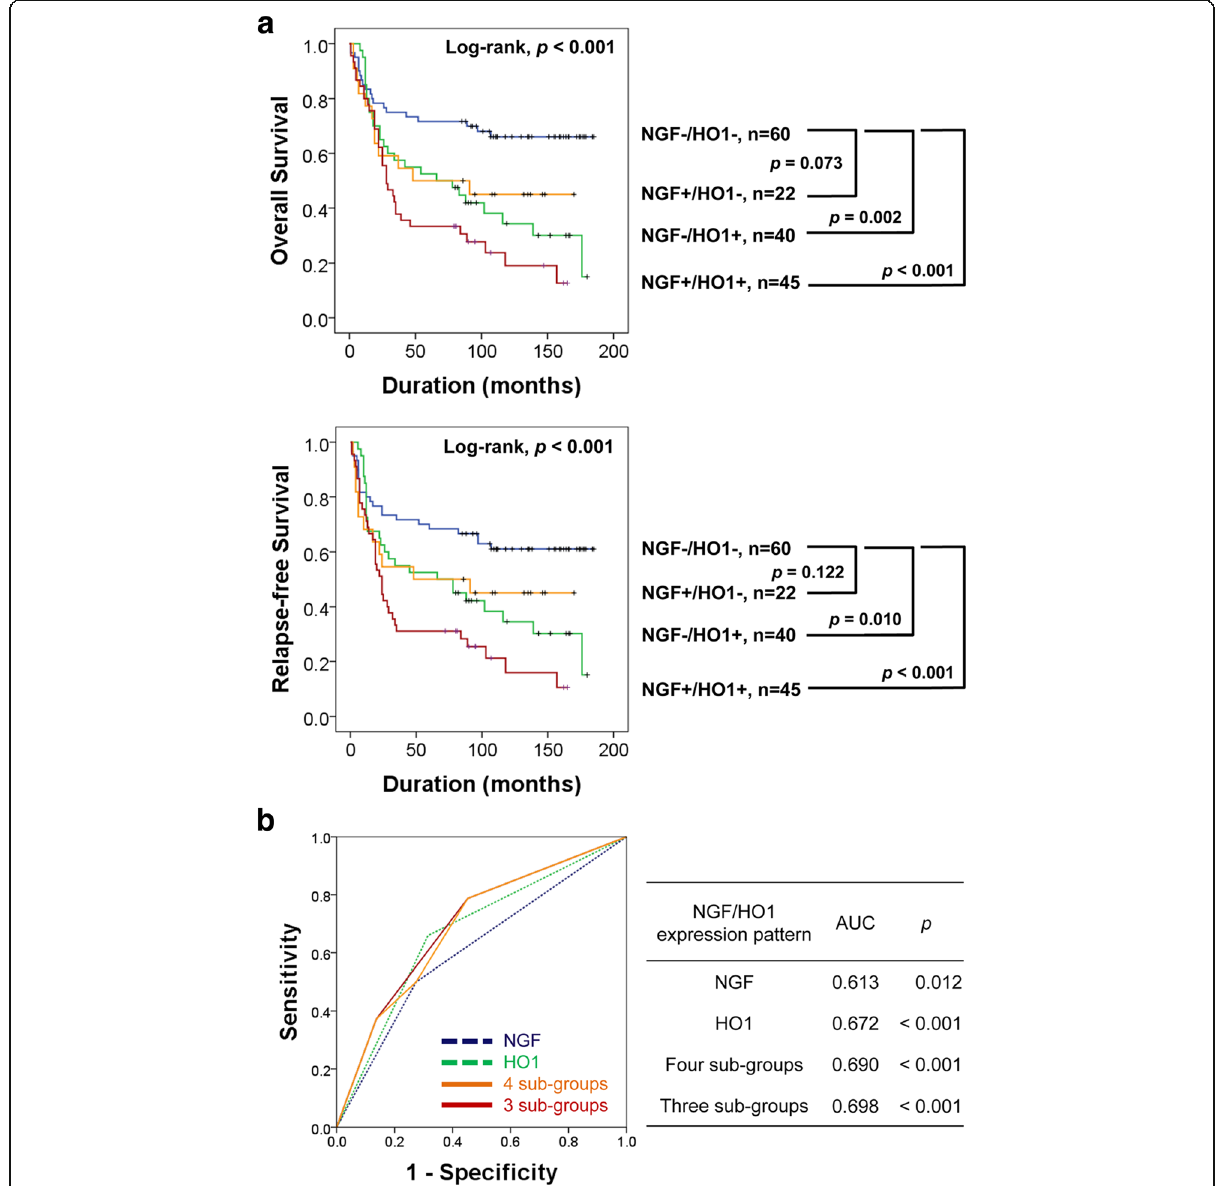
Fig. 3 Kaplan-Meier survival analysis and statistical analysis according to the individual and co-expression pattern of NGF and HO1 in gastric carcinomas. a Gastric carcinomas were grouped into four sub-groups according to co-expression pattern of NGF and HO1 and subjected to Kaplan-Meier survival analysis for the overall survival and relapse-free survival. NGF − /HO1 − , NGF-negative and HO1-negative. NGF + /HO1 − , NGF-positive and HO1-negative. NGF − /HO1 + , NGF-negative and HO1-positive. NGF + /HO1 + , NGF-positive and HO1-positive. b Receiver operating characteristic curve analysis for the event of overall survival (death of patients) according to the NGF-positivity, HO1-positivity, and co-expression pattern of NGF and HO1 sub-grouping gastric carcinomas into four or three. The area under the curve is largest when the gastric carcinomas are divided to three sub-groups according to co-expression pattern of NGF and HO1 (NGF − /HO1 − , NGF + /HO1 − or NGF − /HO1 + , and NGF + /HO1 +